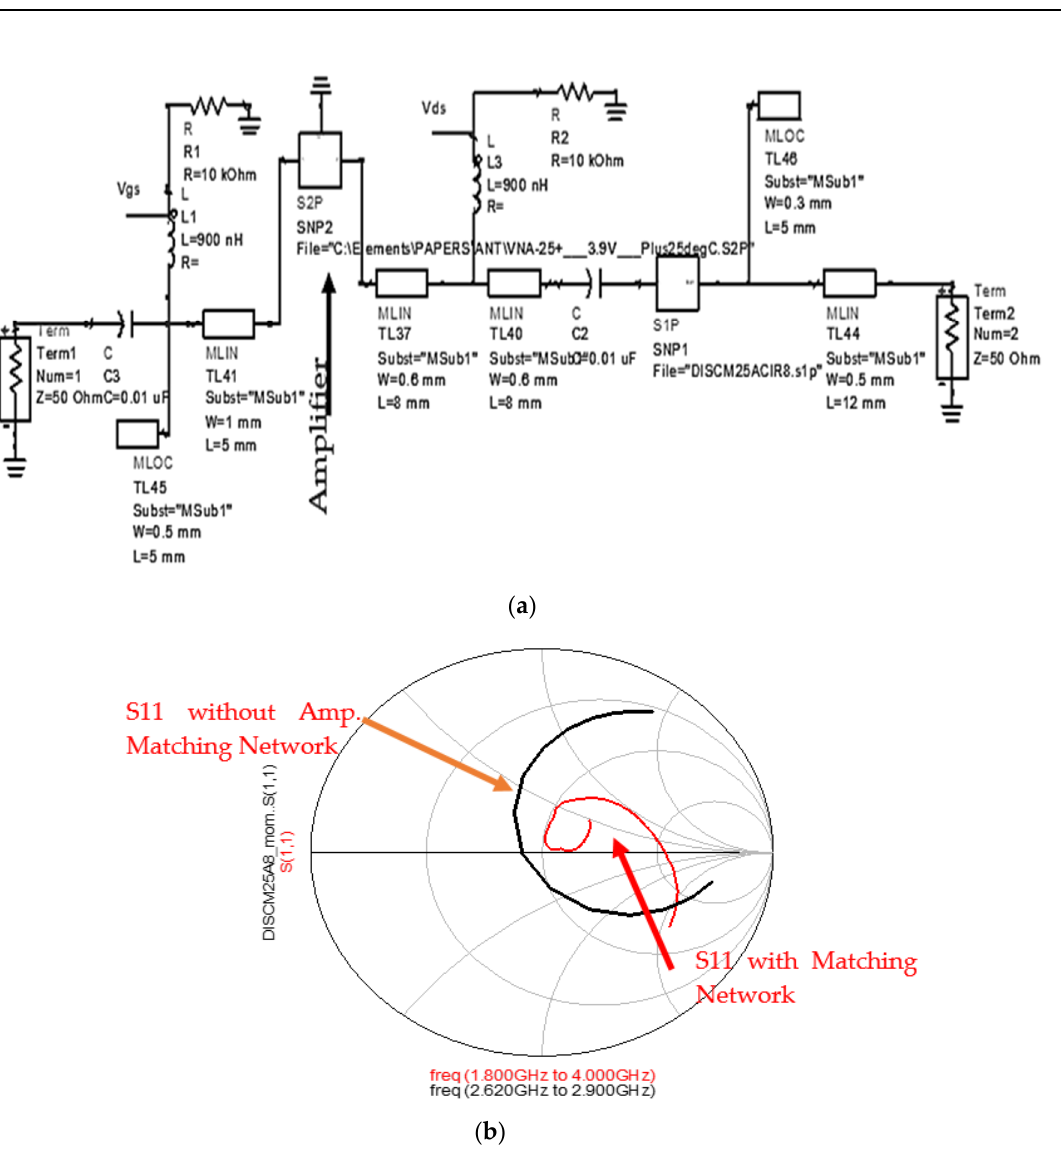
Figure 15. Optimized Active Transmitting antenna: ( a ) Matching circuit; ( b ) S11 Smith chart diagram.